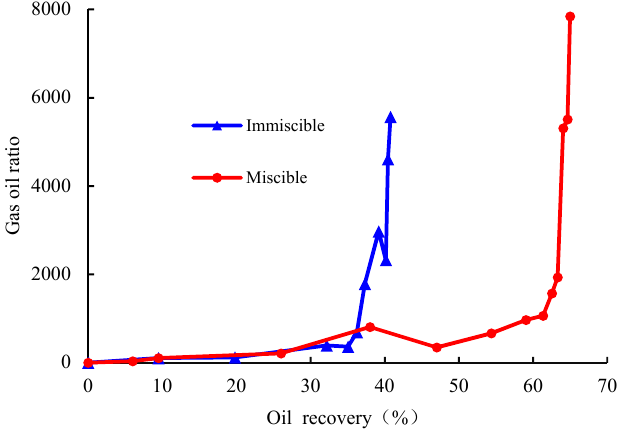
Figure 8. Relationship between injection volume and storage percentage. Figure 8. relationship between injection volume and storage percentage.